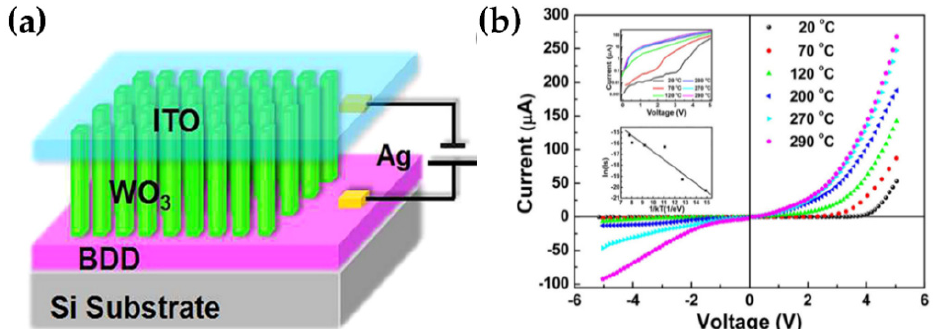
Figure 12. ( a ) Schematic diagram of the n − WO 3 NRs/p − BDD heterojunction device. ( b ) I − V plots of the n − WO 3 NRs/p − BDD heterojunction working at varying temperatures from 20 °C to 290 °C. The top inset is the plot of log (Current) vs. voltage, and the bottom inset is the plot of ln(Is) vs. 1/kBT to obtain the activation energy. Reproduced from [14], with the permission of AIP Publishing.